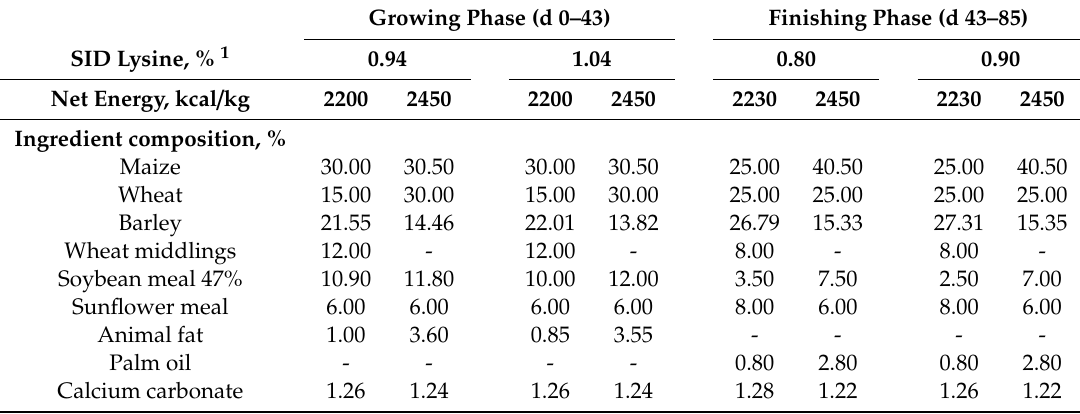
Table 2. Ingredient, calculated and analyzed composition (as fed basis) of the feeds used in Experiment